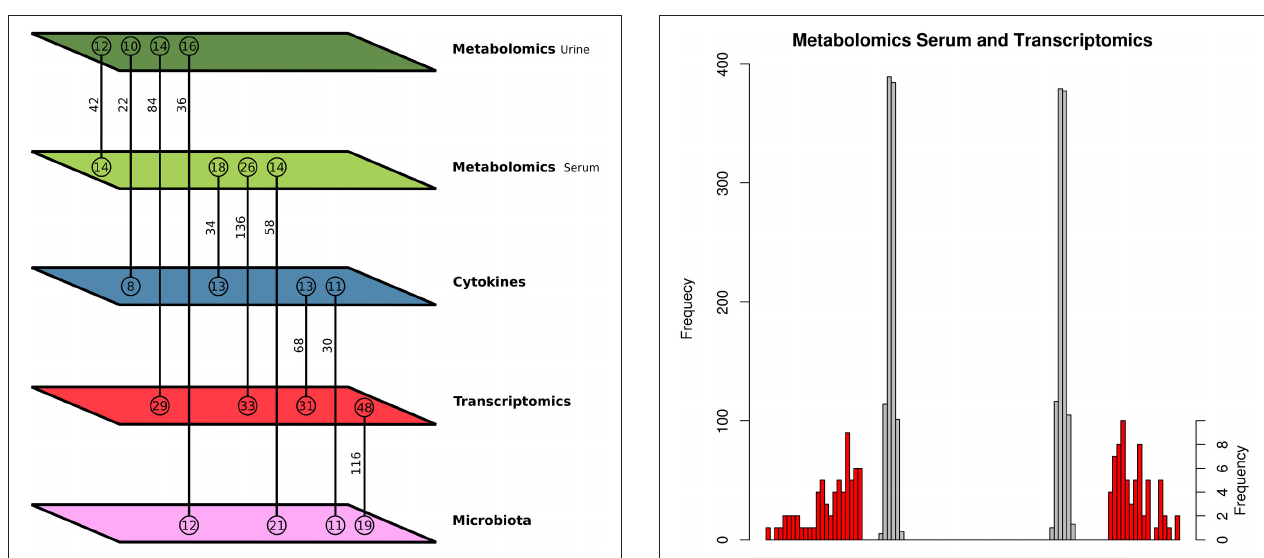
FIGURE 2 | Multilevel integration. This schematic image shows the number of connections between each internal phenotypic level with the other levels in a merged network. The colors of the parallelograms denote the internal phenotypic level to which the data-types belong. Green is Metabolomics (light green—Metabolite from Serum and dark green—Metabolite from Urine), blue is Cytokines, red is Transcriptomics, and pink is Microbiota. Each line connects two levels and the vertical number above the line indicates the number of edges in the correlation network between those two phenotypic levels. The number of connected nodes in each level is given in circles above and below the connecting lines.